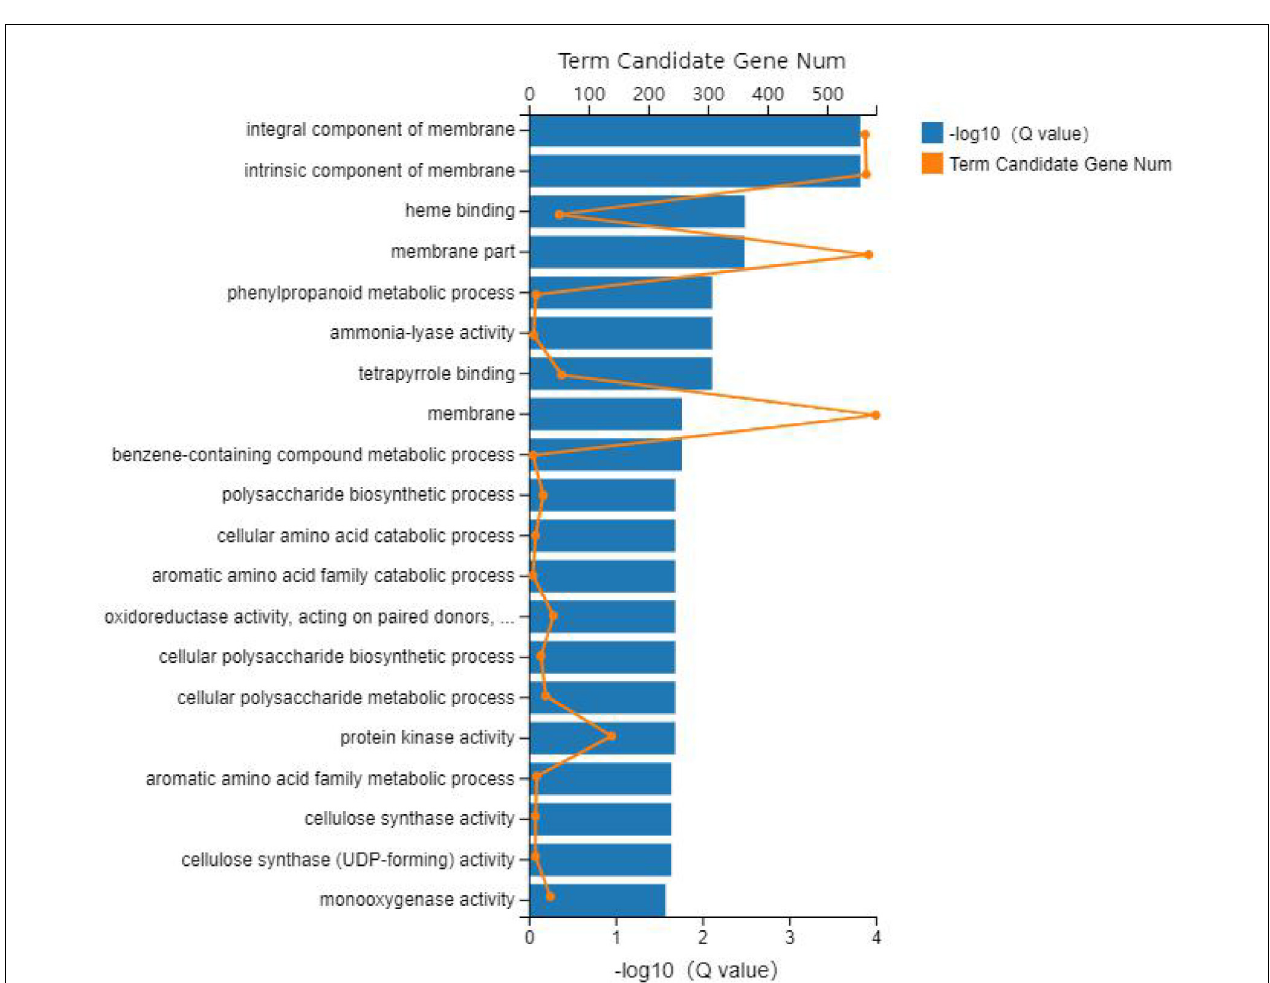
FIGURE 3 | GO enrichment figure of 2,099 DEGs in the seed coat of hulled C. pepo .